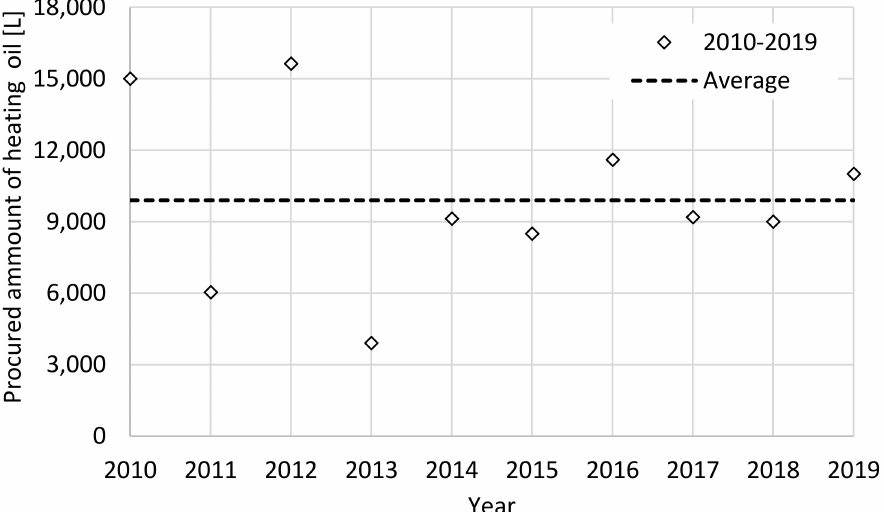
Figure 2. Procurement of heating oil in the period from 2010 to